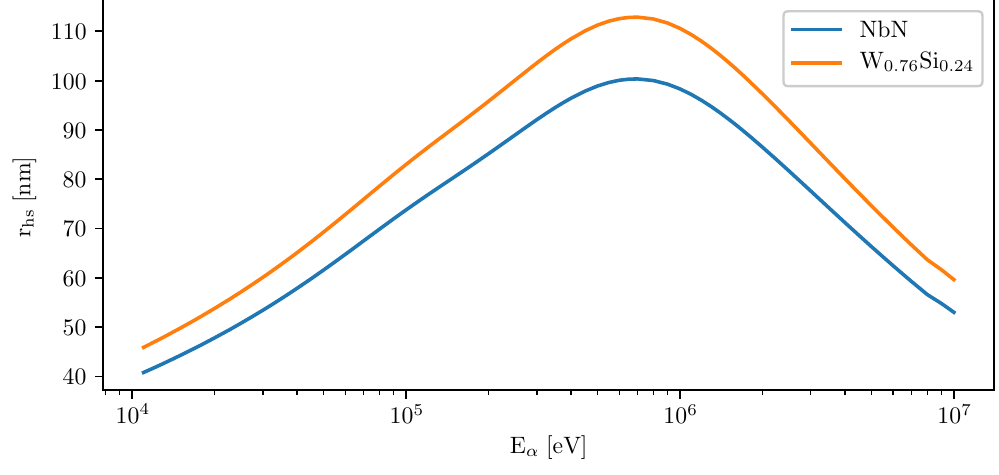
Figure 4. Approximate thermal hotspot radius r hs as a function of α -particle kinetic energy in NbN film with T C = 8K and W 0.76 Si 0.24 film with T C = 3.35 K. Both films are assumed to be held at T 0 = T C